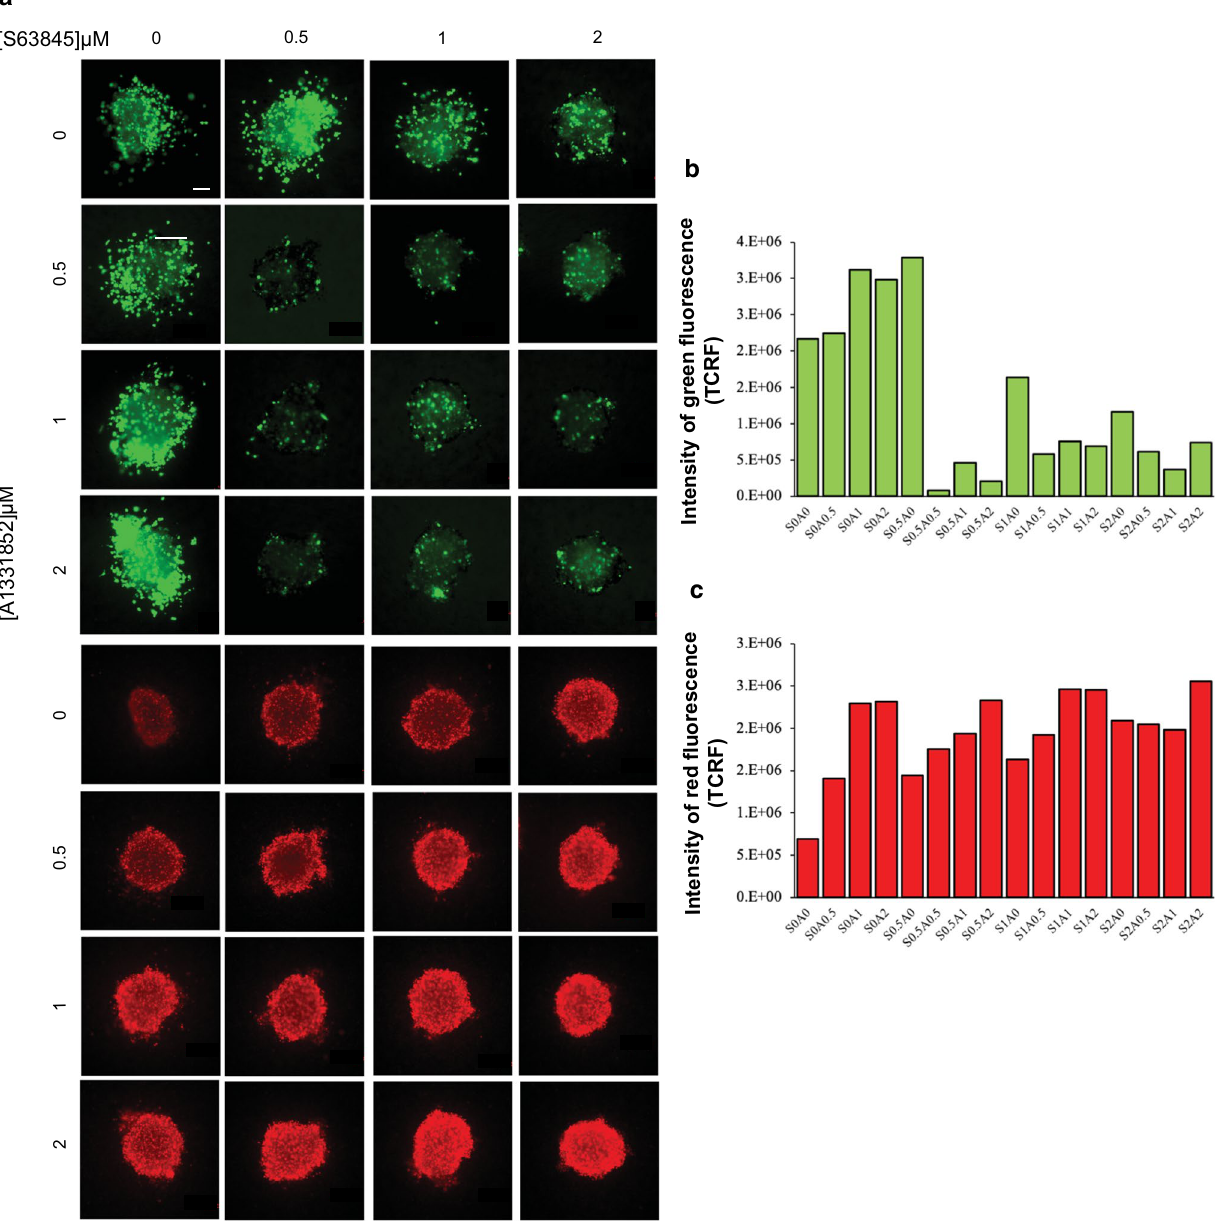
Fig. 3 The effect of the combination of S63845 and A-1331852 on the growth and invasion of HK-1 spheroids over 3 days. a The spheroids were treated with single agents S63845 and A-1331852 and a combination of both over three days at the indicated concentrations, n = 2–3 spheroids per combination. Cell viability was determined using the live/dead assay (Viable cells: stained green by Calcein-AM; Dead cells: stained red by Ethidium-homodimer I). Size bar: 200 μm. The intensity of b green and c red fluorescence was measured for each drug combi- nation and presented as TCRF, n = 2 spheroids per combination. TCRF: Total Corrected Red Fluorescence; “S” denotes S63845 and “A” denotes A-1331852. The numbers next to “S” and “A” indicate the doses of the drug